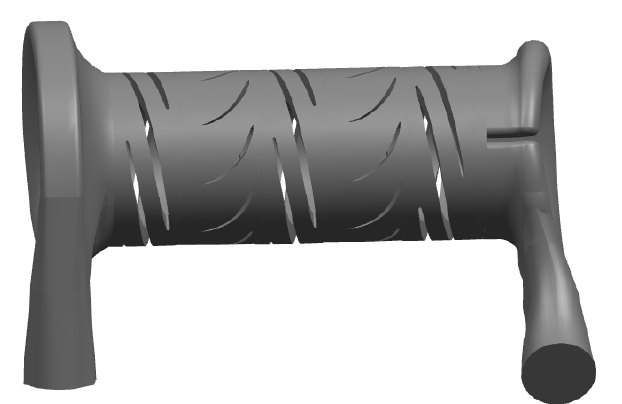
Figure 1. Impeller and diffuser meridian parameters.